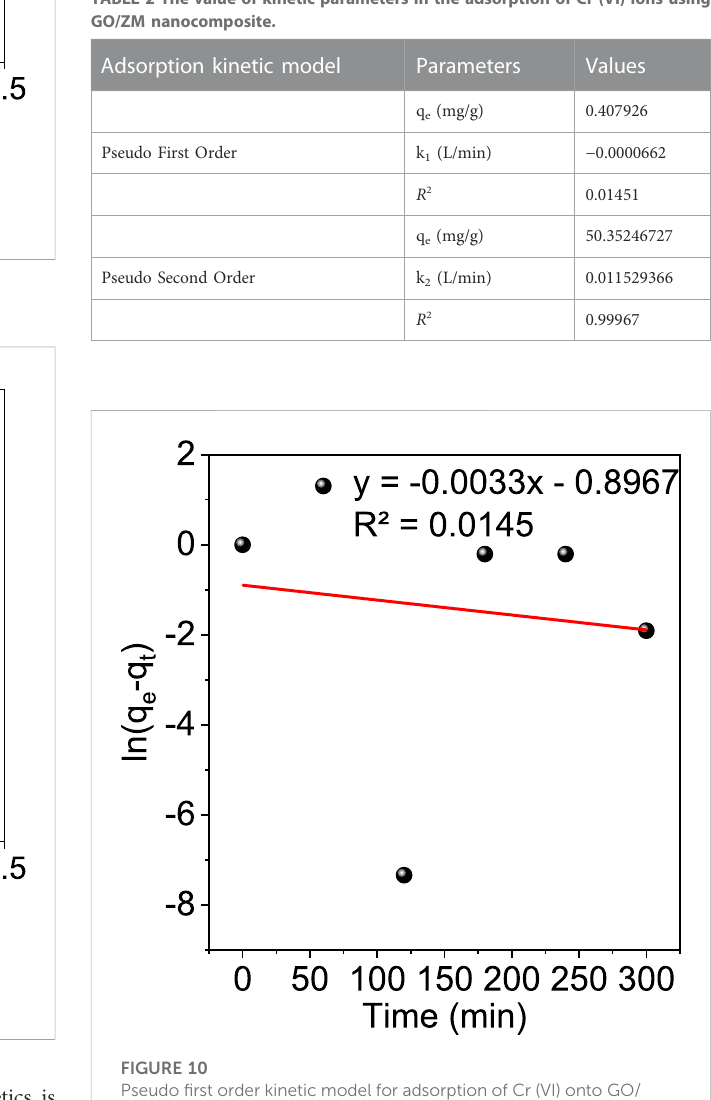
TABLE 2 The value of kinetic parameters in the adsorption of Cr (VI) ions using GO/ZM nanocomposite.